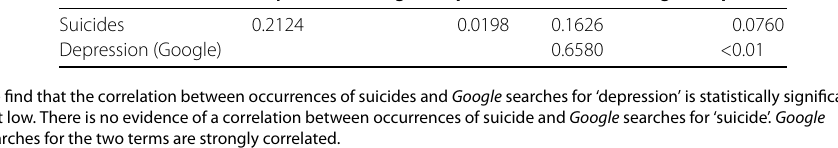
Table 3 Coefficients for correlations between data on Google searches for ‘depression’ and ‘suicide’ and official data on suicide occurrences Depression (Google) p -value Suicide (Google) p -value Suicides